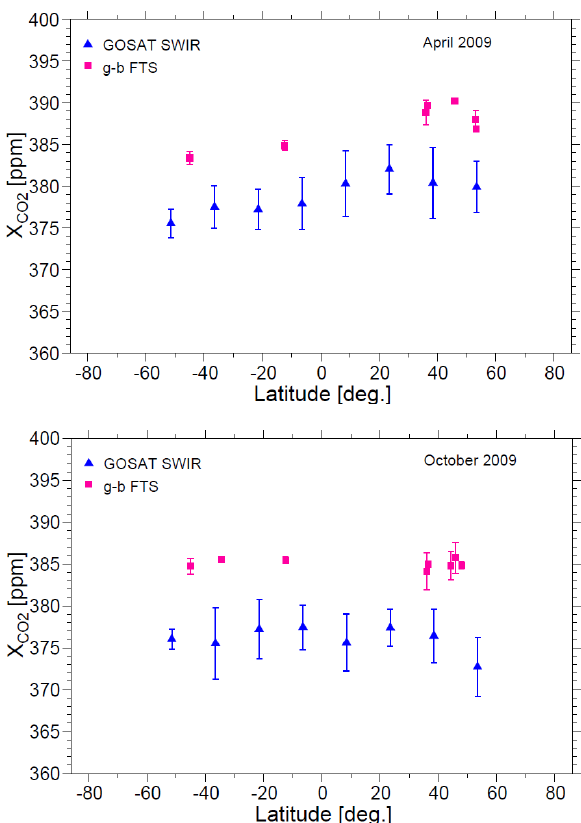
Fig. 8. Latitudinal distributions of monthly means of zonal aver- aged GOSAT X CO for each 15 latitudinal band in April and Oc- 2 tober 2009 (blue triangles). The monthly means of g-b FTS data observed during local time of about 12:30–13:30 hour are shown by pink squares. Vertical bars indicate the standard deviation.